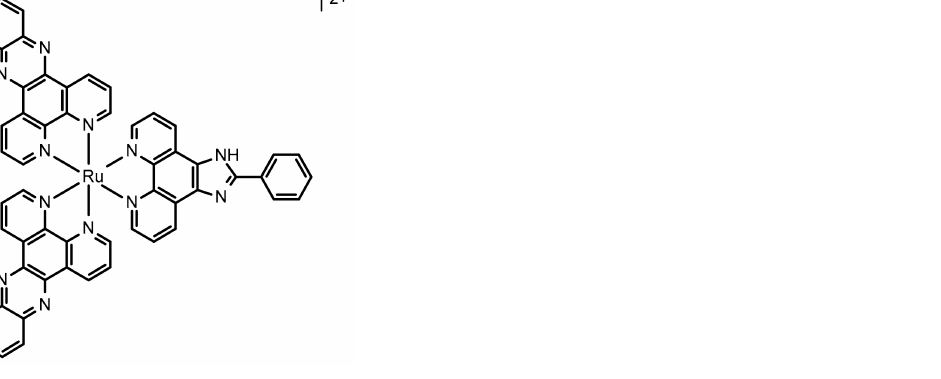
Figure 1. Chemical structure of Ru-PIP ([Ru(dppz) 2 PIP] 2+ (dppz: dipyridophenazine, PIP: (2-(phenyl)- imidazo[4,5-f